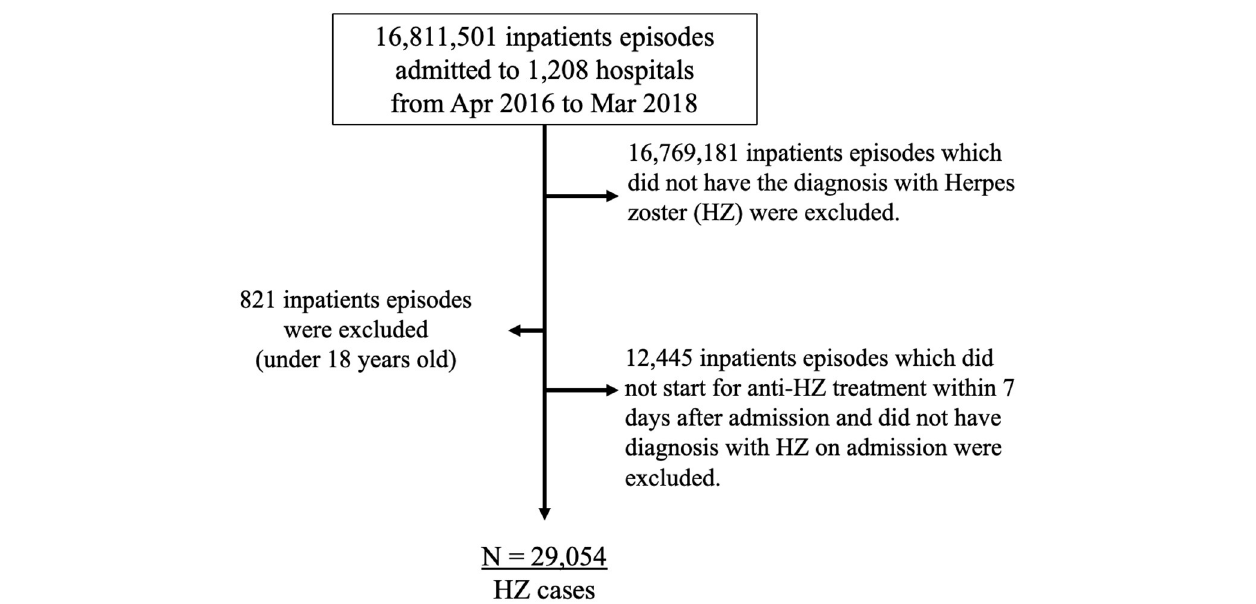
FIGURE 1 | Flowchart of eligible and ineligible participants. HZ, herpes